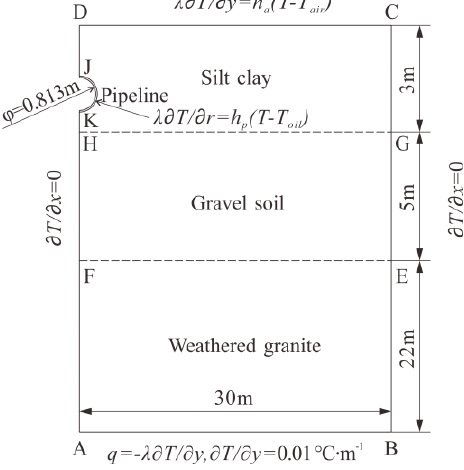
Figure 4. Diagram of thermal boundary conditions of the model in cross-section.